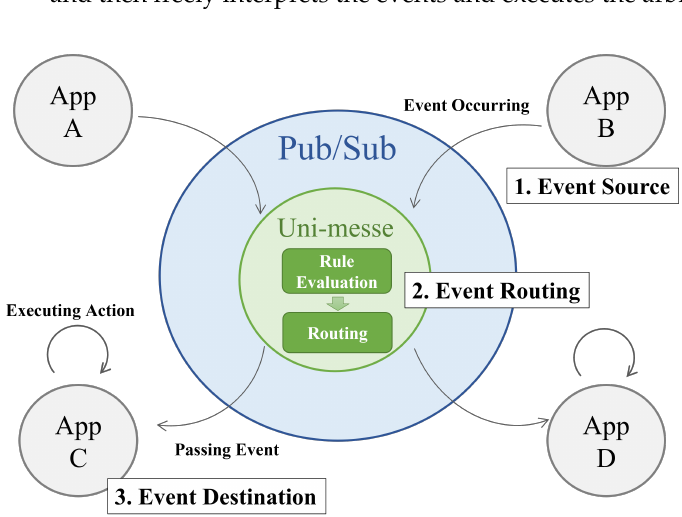
Figure 1. The Uni-messe